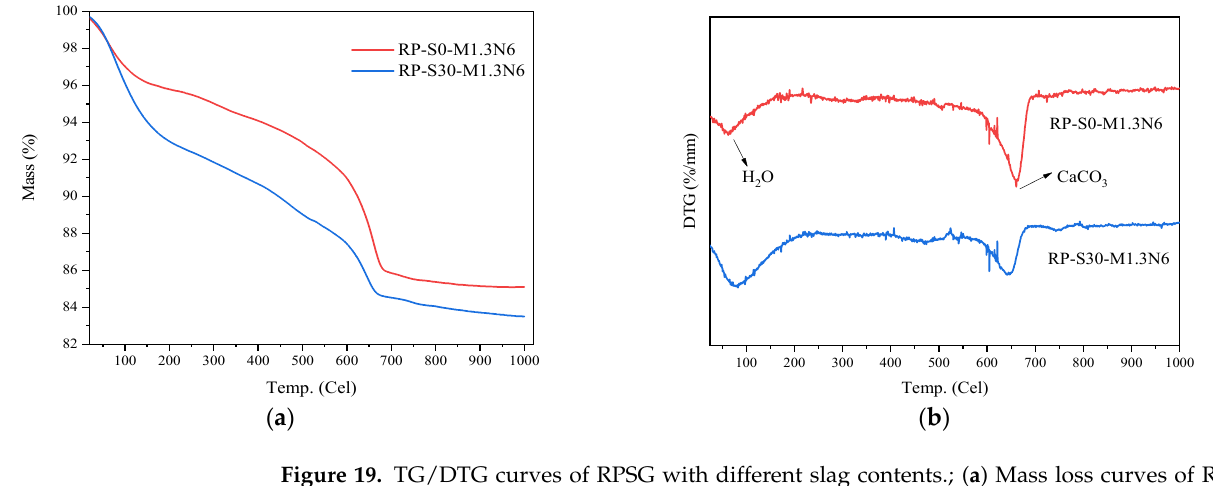
Figure 19. TG/DTG curves of RPSG with different slag contents.; ( a ) Mass loss curves of RPSG; ( b ) DTG curves of RPSG.